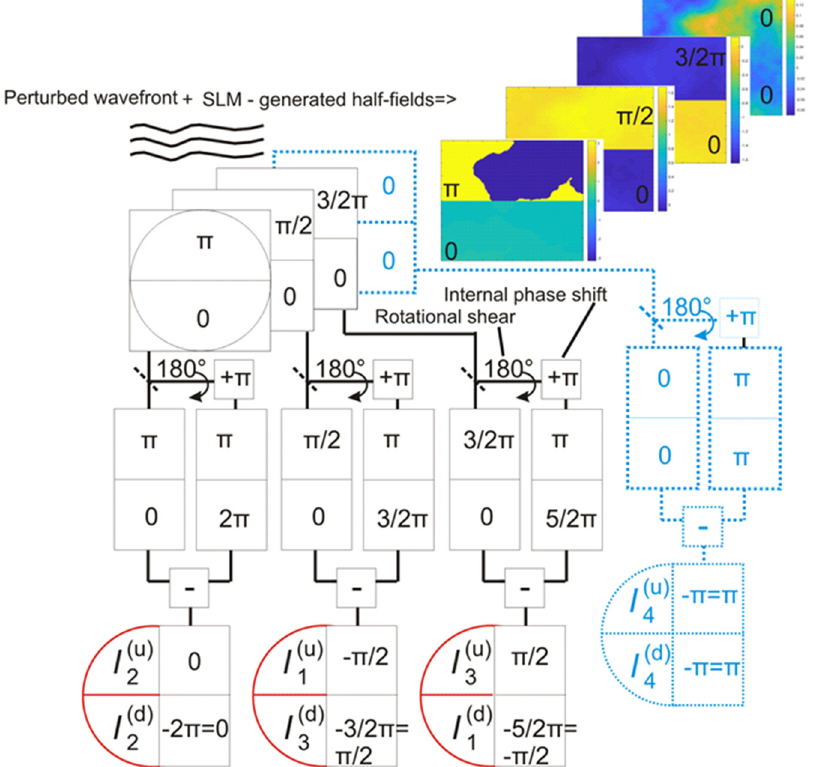
Figure 3. Phase modulation provided in the pupil semi ‐ plane. Denoted are intensity values 𝐼 (cid:2869) .. (cid:2871)(cid:4666)(cid:2931)(cid:4667) , 𝐼 (cid:2869) .. (cid:2871)(cid:4666)(cid:2914)(cid:4667) used by the three ‐ step PSI; the subscripts (u) and (d) stand for the upper and lower halves of the pupil; an additional phase modulation with the corresponding intensities of 𝐼 (cid:2872)(cid:4666)(cid:2931)(cid:4667) , 𝐼 (cid:2872)(cid:4666)(cid:2914)(cid:4667) for the four ‐ step PSI algorithm is in blue.